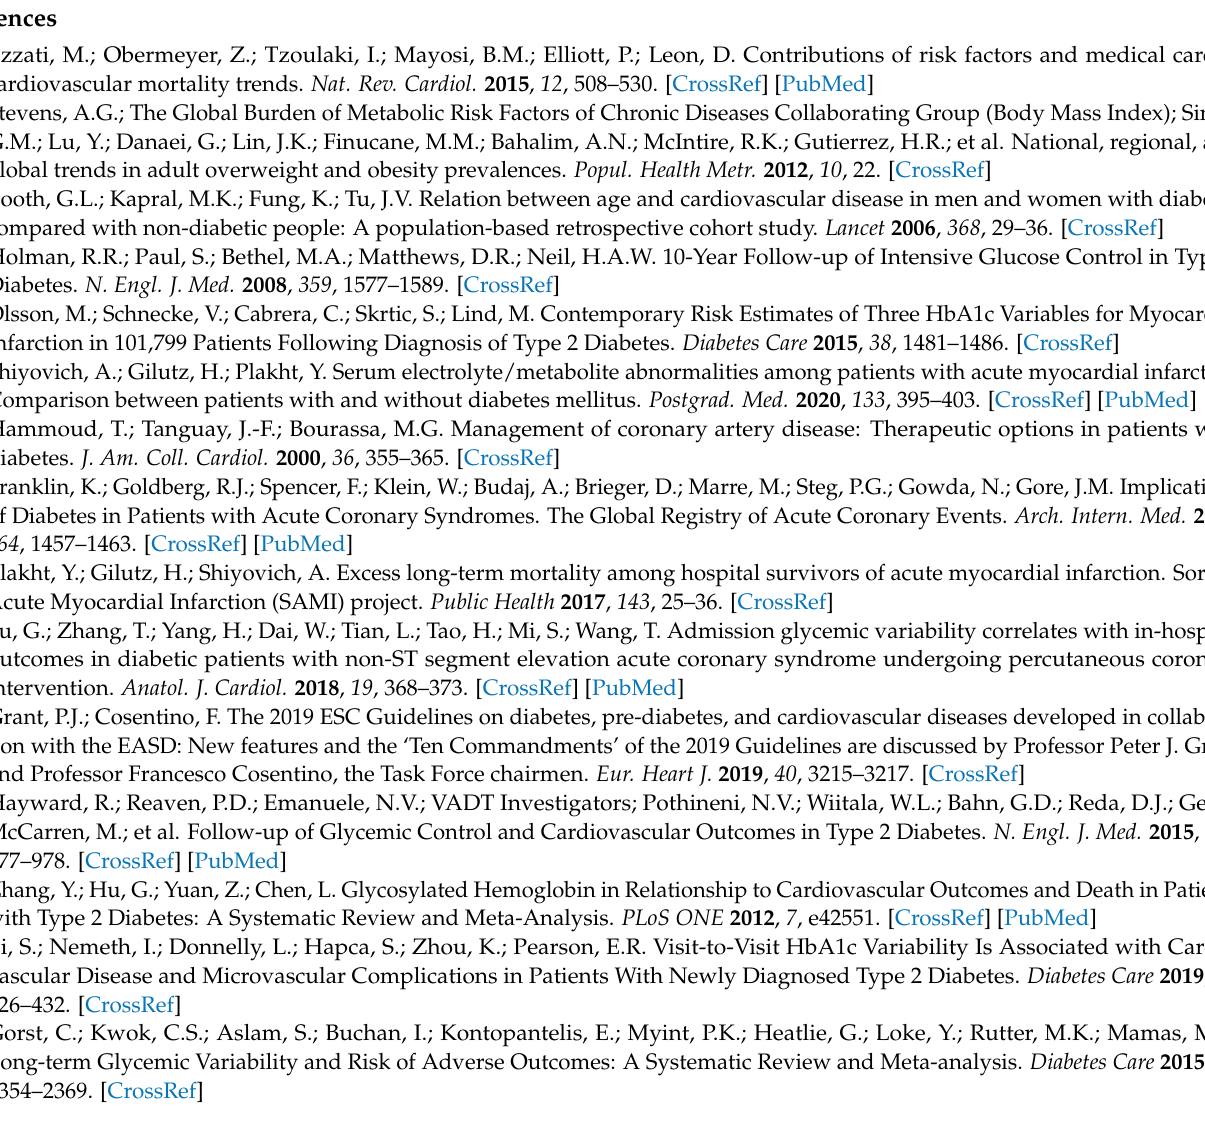
Figure A2. Mortality rates (%) according to the ∆ HbA 1C category in the rapid- and slow-changing groups. Rapid change— time interval of ∆ HbA 1C values < one year; slow change—time interval of ∆ HbA 1C values ≥ one year.